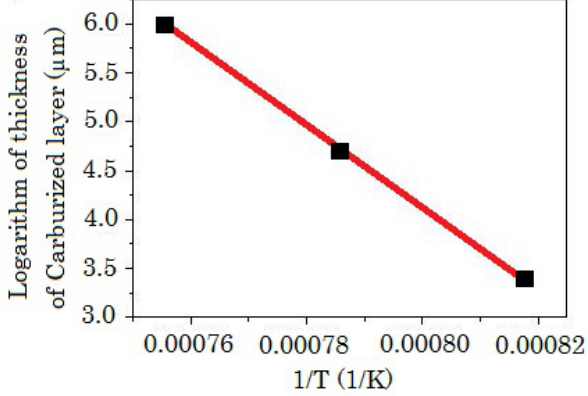
Figure 9. Arrhenius plot of the temperature dependence of the carburized layer thickness.